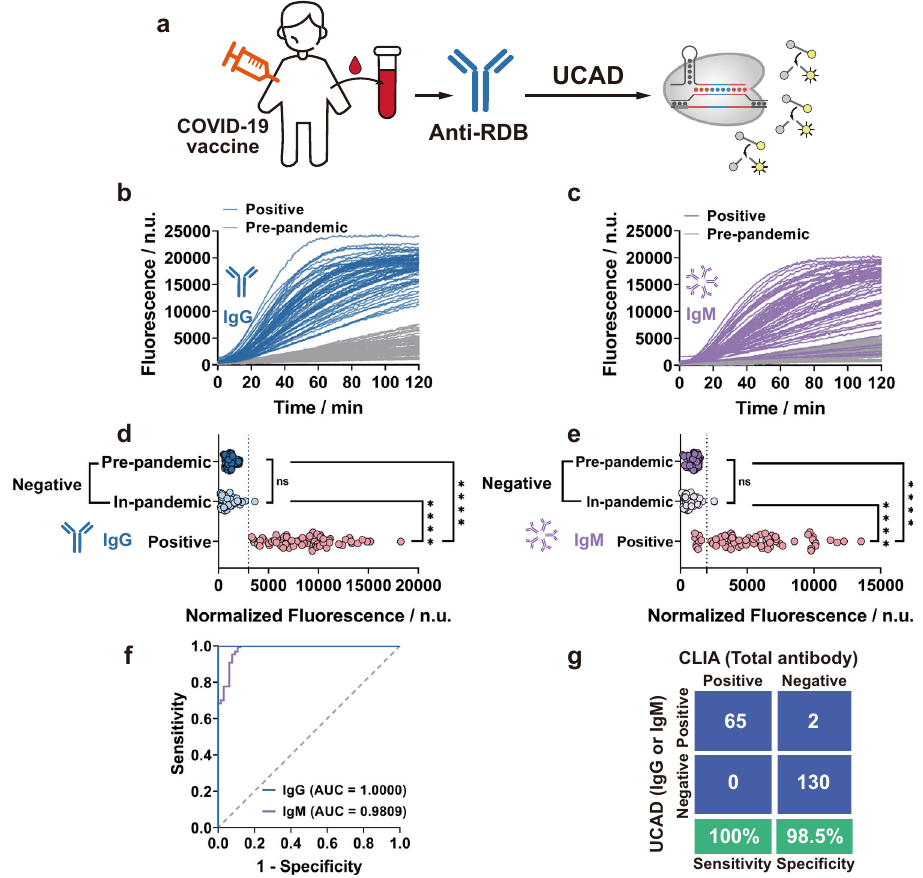
Fig. 3 | Clinical validation of UCAD. a Schematic illustration of the work fl ow for clinical validation of UCAD. b , c Kinetic curves for the detection of anti-RBD IgG ( b ) and IgM ( c ) in 65 anti-RBD positive sera collected from healthy individuals who received two shots of inactivated COVID-19 vaccine and 77 pre-pandemic sera. d , e Endpoint fl uorescence signals at 40min of three clinical cohorts, including 77 pre-pandemic samples, 65 positive samples, and 55 presumptive negative sera collected during the pandemic. Both the anti-RBD IgG and IgM levels of the positive cohort ( n =65) were signi fi cantly higher than those of the pre-pandemic ( p =6.76e − 27 for IgG and p =9.15e − 15 for IgM) and in-pandemic negative cohorts ( p =1.44e − 20 for IgG and p =2.59e − 18 for IgM). But the pre- pandemic and in-pandemic negative cohorts had no signi fi cant difference ( p =0.2595 for IgG and p =0.0607 for IgM) and were thus combined as one